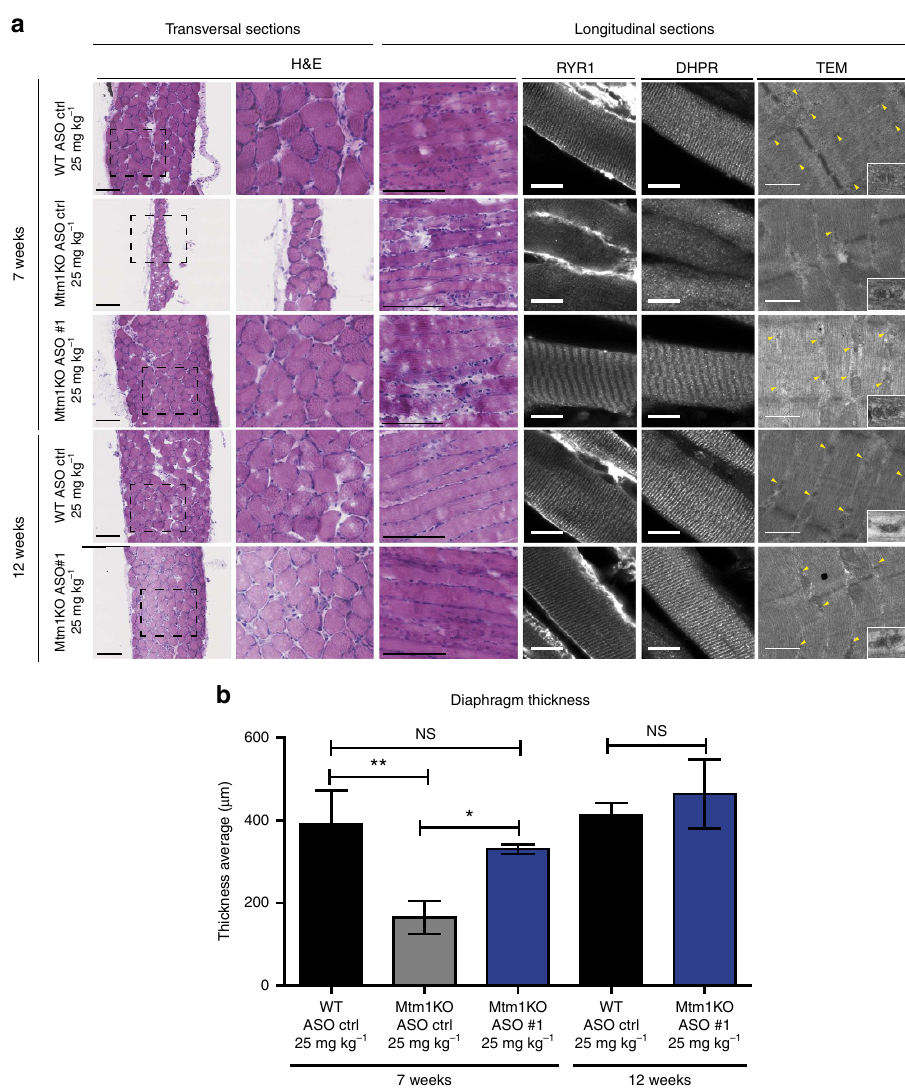
Figure 6 | Diaphragm histology and ultrastructure organization. ( a ) Hematoxylin and eosin (H&E) staining of cross or longitudinal diaphragm sections of WTor Mtm1KO mice treated with ASO control (ctrl) or ASO#1 at different ages (7 or 12 weeks). Scale bars, 100 m m. These longitudinal sections have been immunostained with antibodies against RYR1 and DHPR. Scale bars, 10 m m. The ultrastructure of diaphragm was analysed using electronic microscopy to assess the sarcomere organization and triad formation and shape (yellow arrows). Scale bars, 500nm. ( b ) Graph depicting mean ± s.e.m. of quantification of diaphragm transversal sections thickness. n ¼ 4–5 samples. NS, not statistically significant, * P o 0.05, ** P o 0.01 (ANOVA test followed by post hoc